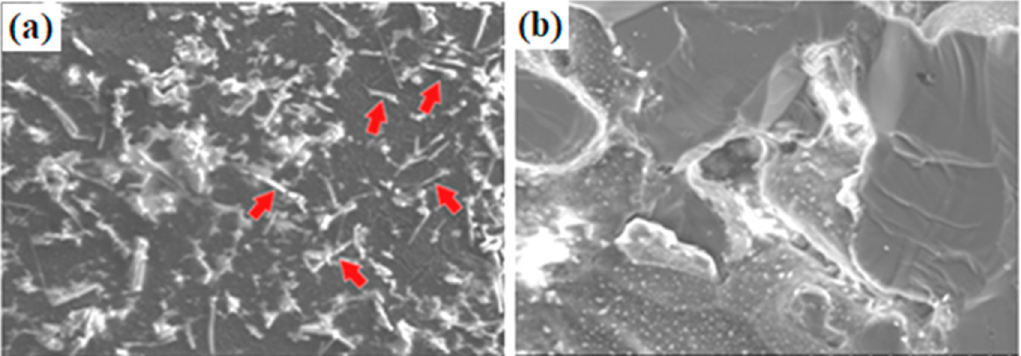
Figure 9. ( a ) Surface SEM image, where red arrows represent whiskers; ( b ) cross-section of multi-layer coatings after thermal cyclic oxidation test between 1773 K and room temperature 40 times.